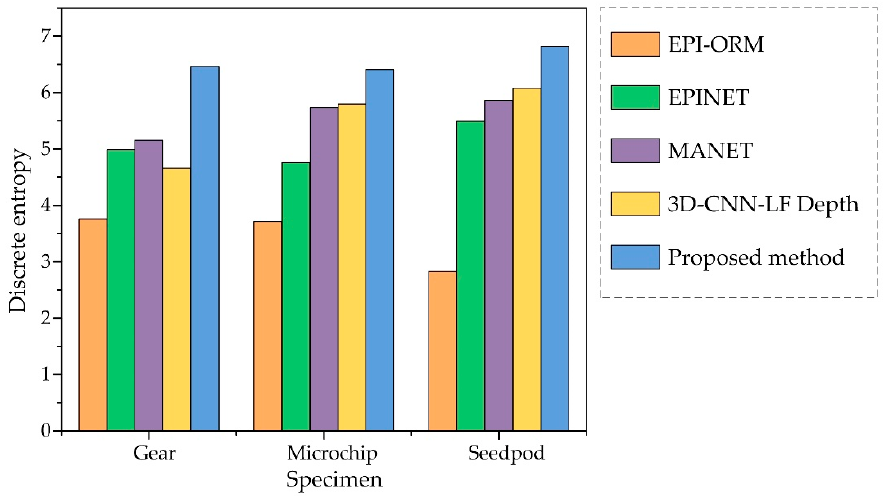
Figure 9. Discrete entropy values for gear, microchip, and seedpod using EPI-ORM [32], EPINET [27], MANET [38], and 3D-CNN-LF Depth [39] proposed depth estimation methods. Based on estimated depth map and point cloud interpolation, reconstructed 3D point cloud models were created as shown in Figure 10. Using surface subdivision-based points interpolation, a 3D point cloud of the gear, microchip, and seedpod was created using 2D images and the proposed depth map. In addition to the gear, the microchip, and the seedpod were regenerated using 3D point clouds (562,500 object points for the gear, more points than the original generation.